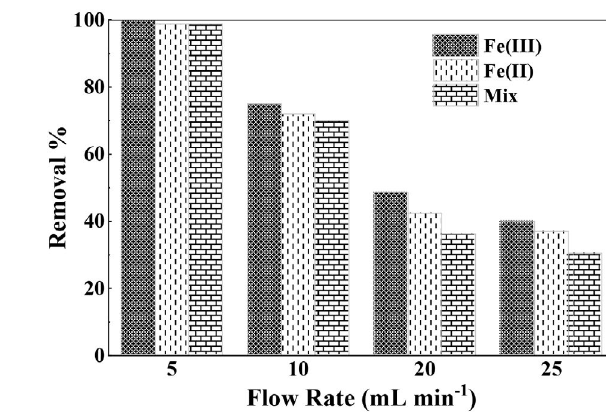
Fig. 5. Effect of flow rate on the adsorption of Fe(III) and/or Fe(II). Conditions: pH = 4.0; T = 25 °C; mesh particle size = 100 BSS